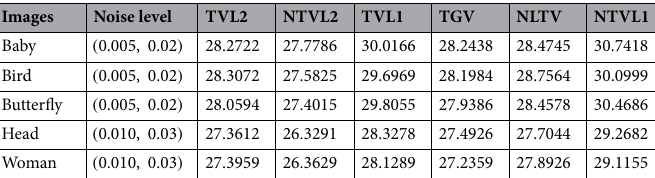
Table 5. The PSNR of the restored images in Set5.